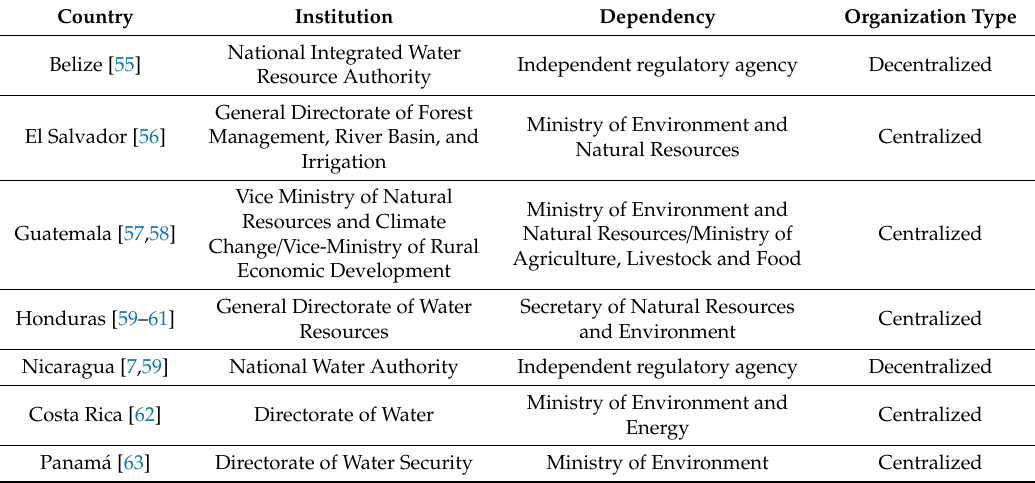
Table 1. Water organizations arrangement in Central American